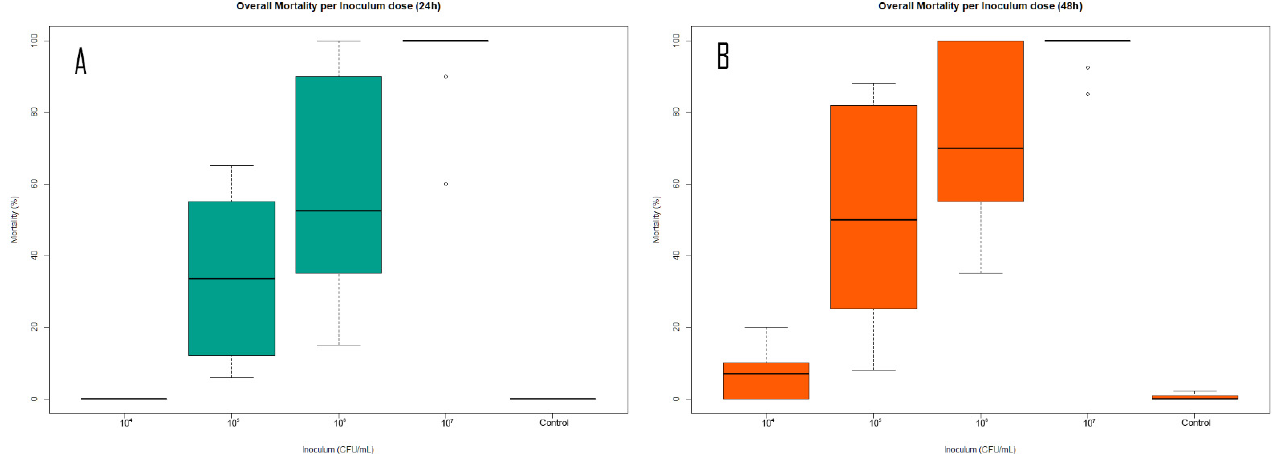
Figure 3. Overall dose-dependent response observed for the different inoculum concentrations used. ( A ) 24 h past initial exposure. ( B ) 48 h past initial exposure.